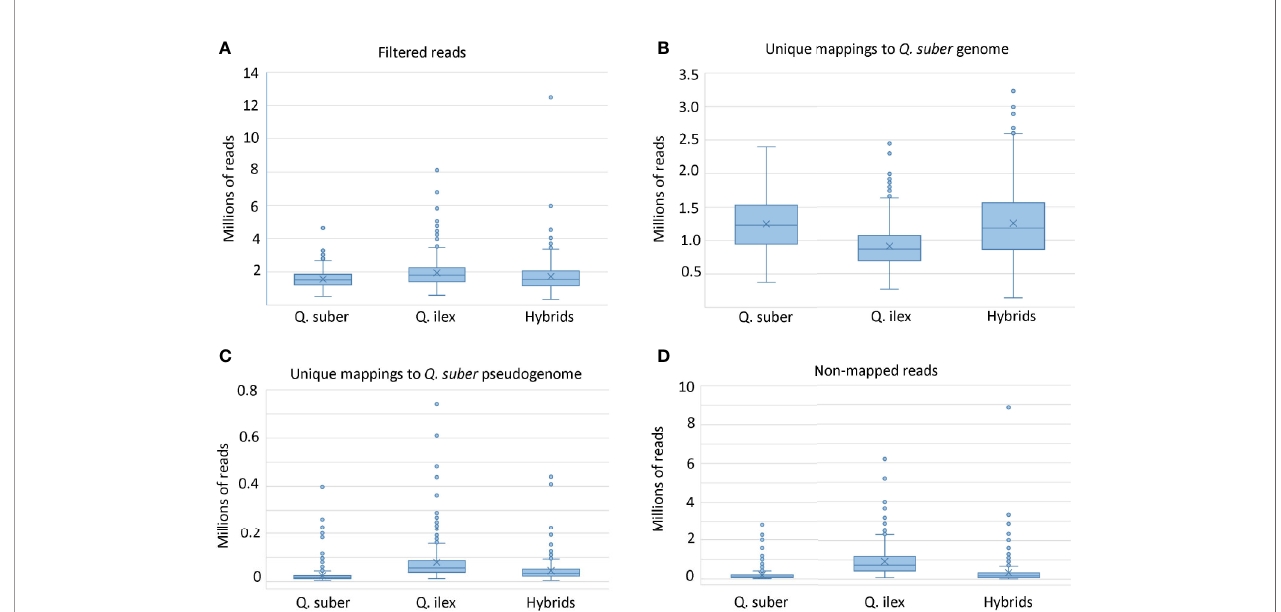
FIGURE 3 | Box and whisker plots of mapping sequences. (A) Total number of reads employed in the ddRADseq pipeline after adapter removal and quality fi ltering. (B) Number of reads uniquely mapped to Q. suber genome assembly (Ramos et al., 2018). (C) Number of reads uniquely mapped to the pseudogenome generated with SoapDeNovo2. (D) Final number of non-mapped